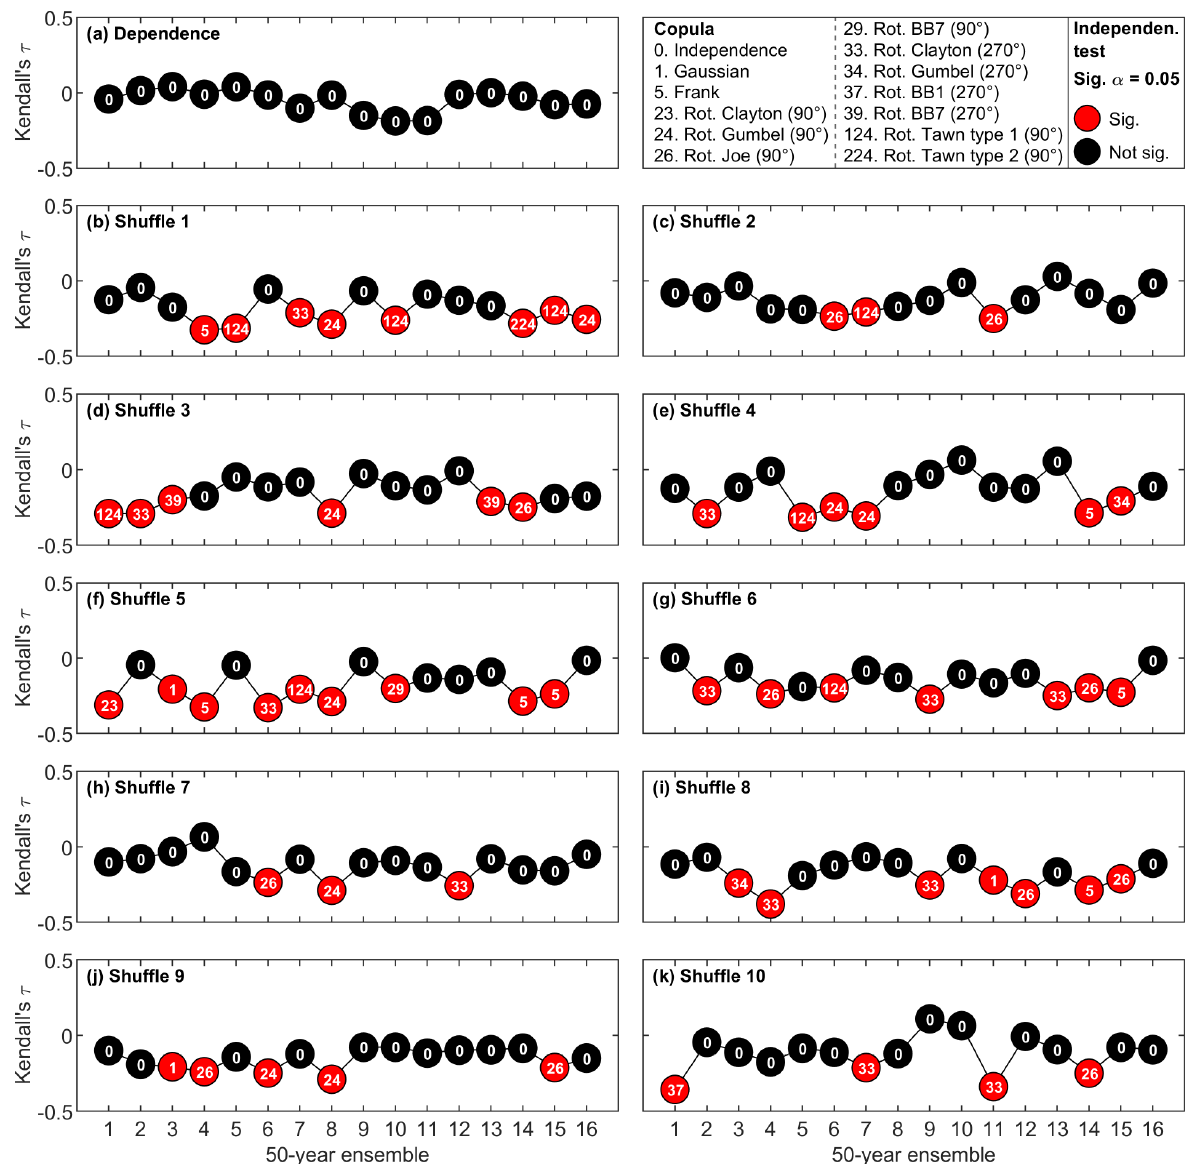
Figure 7. Variability of copula fitting among the sixteen 50-year runs for original (a) and shuffled data (b–k) . Red dots indicate the indepen- dence test is